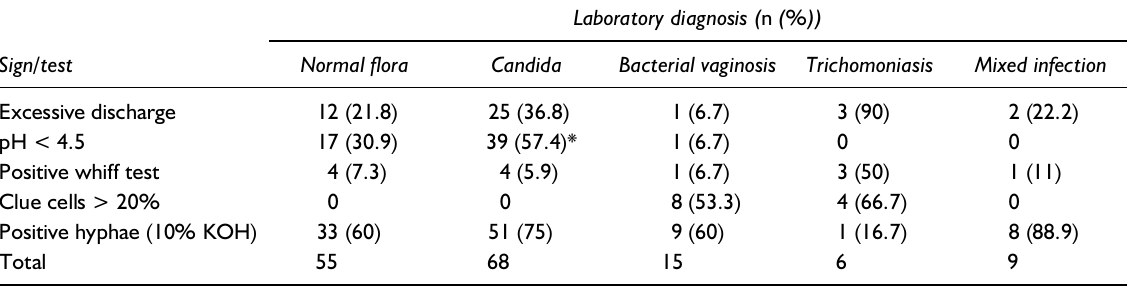
Table 5 Correlation of signs with laboratory diagnosis; numbers in parentheses are percent of cases in the same column. Some women had more than one sign/test